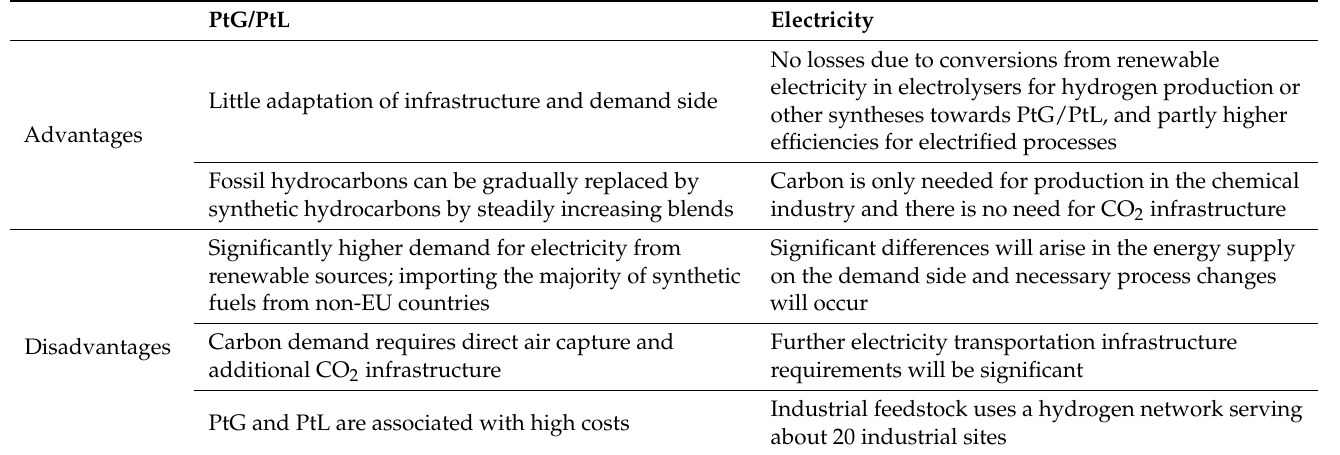
Table 2. Overview of differences between the PtG/PtL and electricity scenario in the long-term and climate scenarios of the BMWi